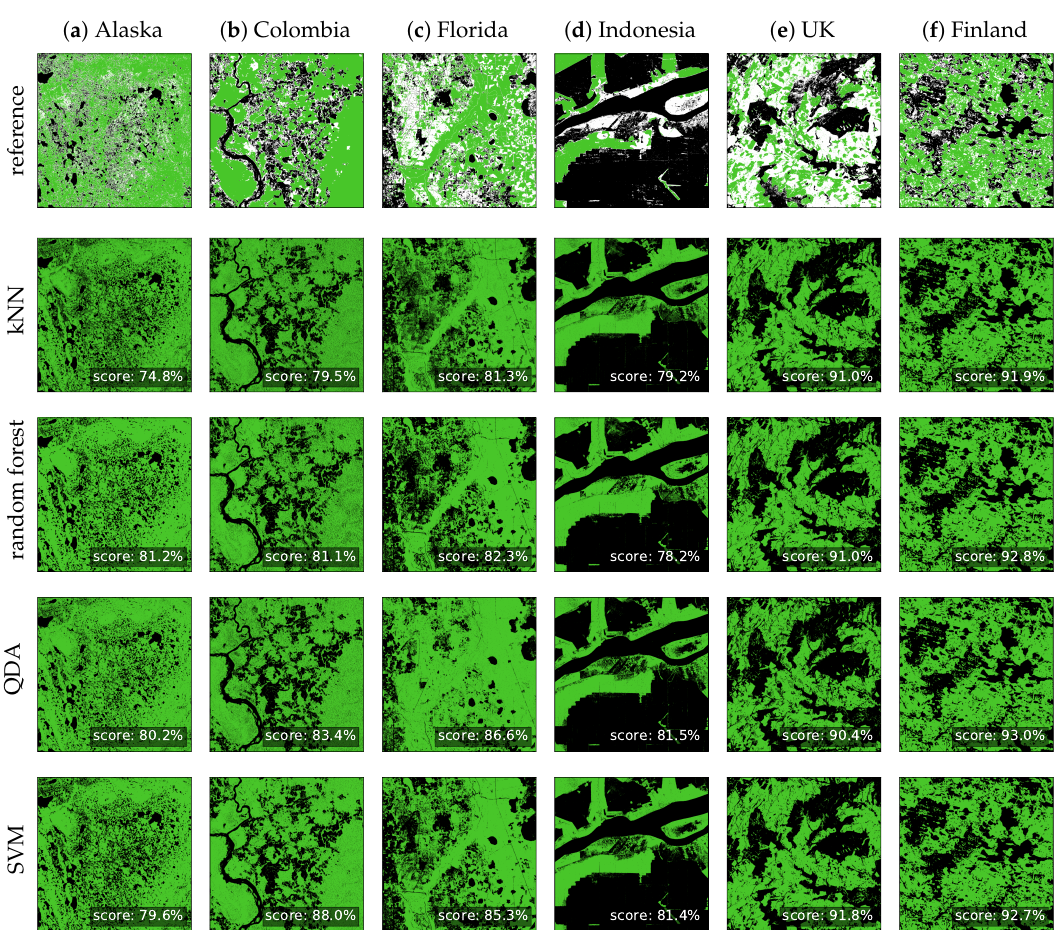
Figure 7. This figure shows classification results with different classifiers, based on the mean and standard deviation (per orbit). For each study site, 10,000 points per class were selected at random for training the classifier. The top row shows the reference data (corresponding to Figure 3), whereas the remaining rows show the predictions obtained from various classifiers. Forest pixels are shown in green, and non-forest pixels in black. Each prediction image also shows the balanced accuracy score compared to the reference